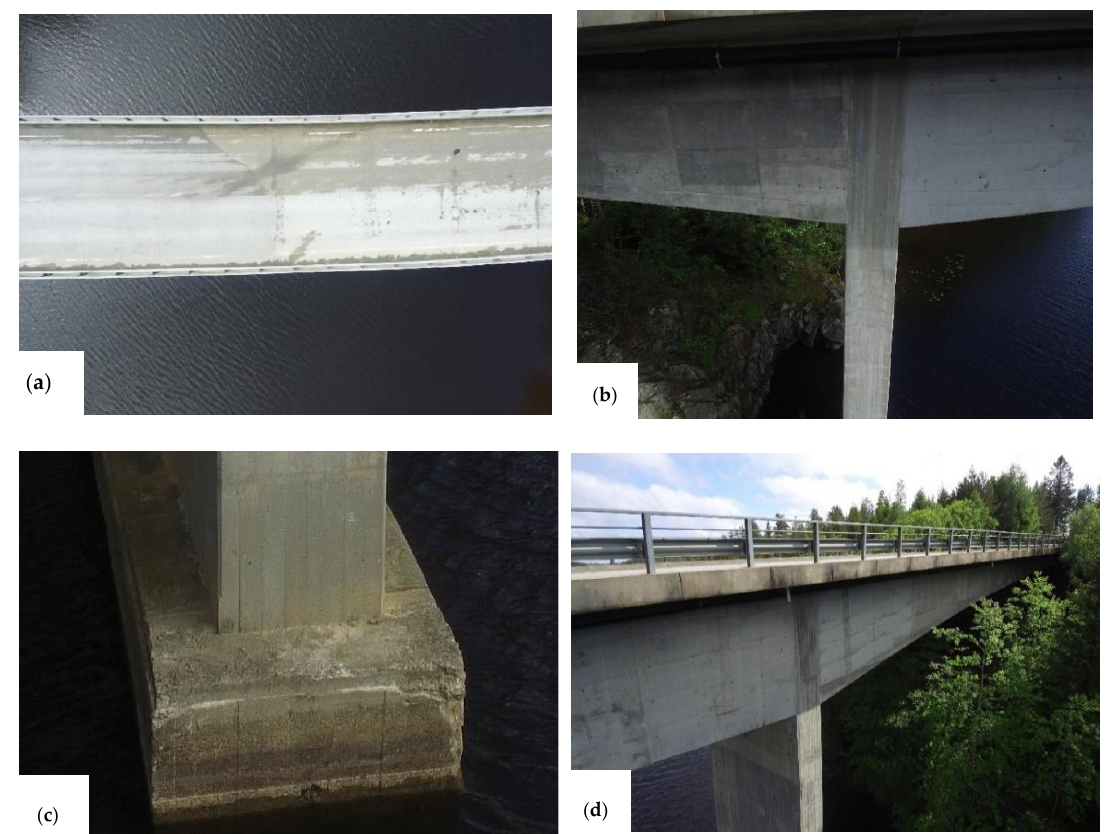
Figure 4. ( a ) Top view of Skodsberg bridge. ( b ) drone image of detail near top deck and footing. ( c ) drone image of concrete deterioration. ( d ) Unmanned Aerial Vehicle (UAV) photo detail near the top deck and footing.